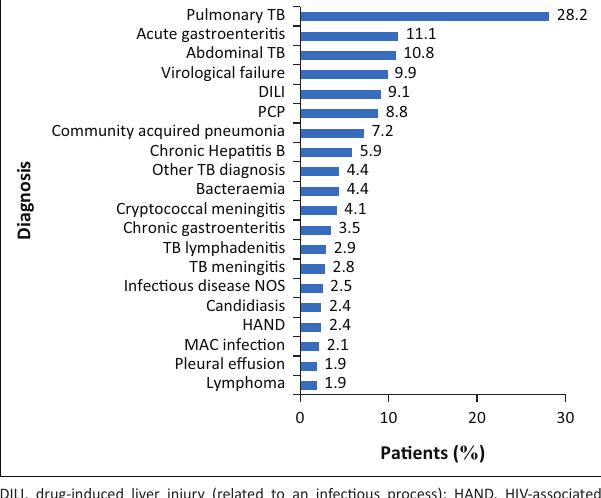
FIGURE 3: Top 20 infectious diagnoses (excluding human immunodeficiency virus) made in individual patients seen by infectious diseases department